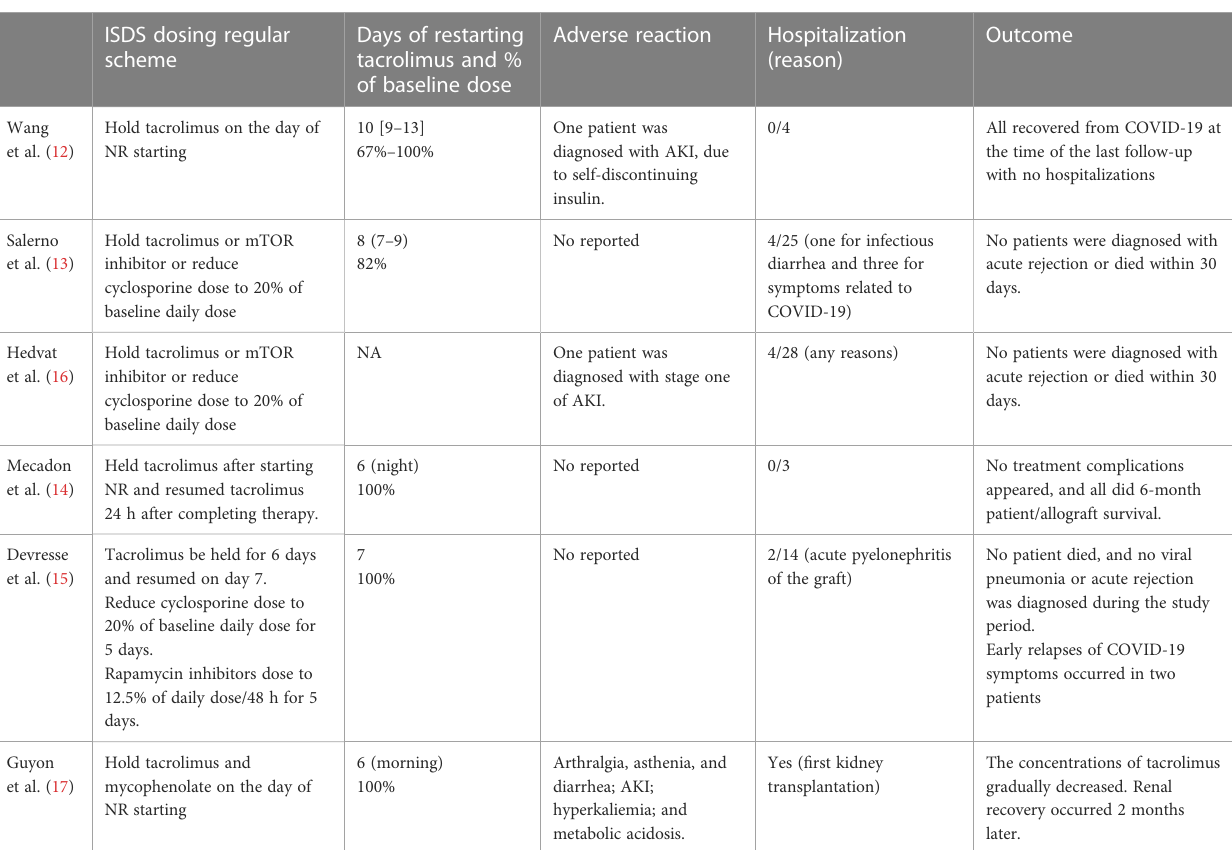
TABLE 2 Studies of holding CNIs/mTOR